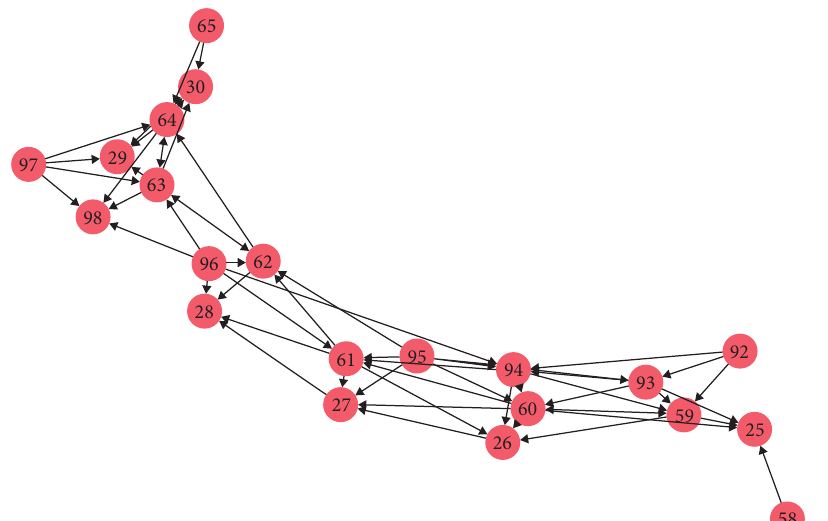
Figure 8: Diagram of a directed weighted network in the section area of the entrance and exit.